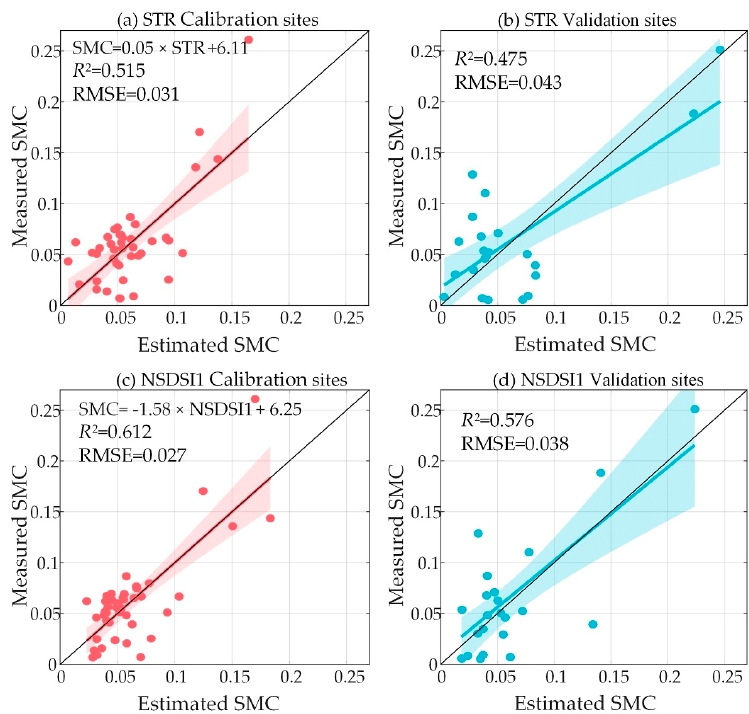
Figure 17. ( a ) Sentinel-2 MSI B11 (1610nm) and B12 (2185nm) vs SMC. ( b ) SMC estimated and measured by using (cid:1840)(cid:1830)(cid:1845)(cid:1839)(cid:1835) (cid:3009)(cid:3028)(cid:3043)(cid:3038)(cid:3032) (calibration sites). ( c ) SMC estimated and measured by using (cid:1840)(cid:1830)(cid:1845)(cid:1839)(cid:1835) (cid:3009)(cid:3028)(cid:3043)(cid:3038)(cid:3032) (validation sites).